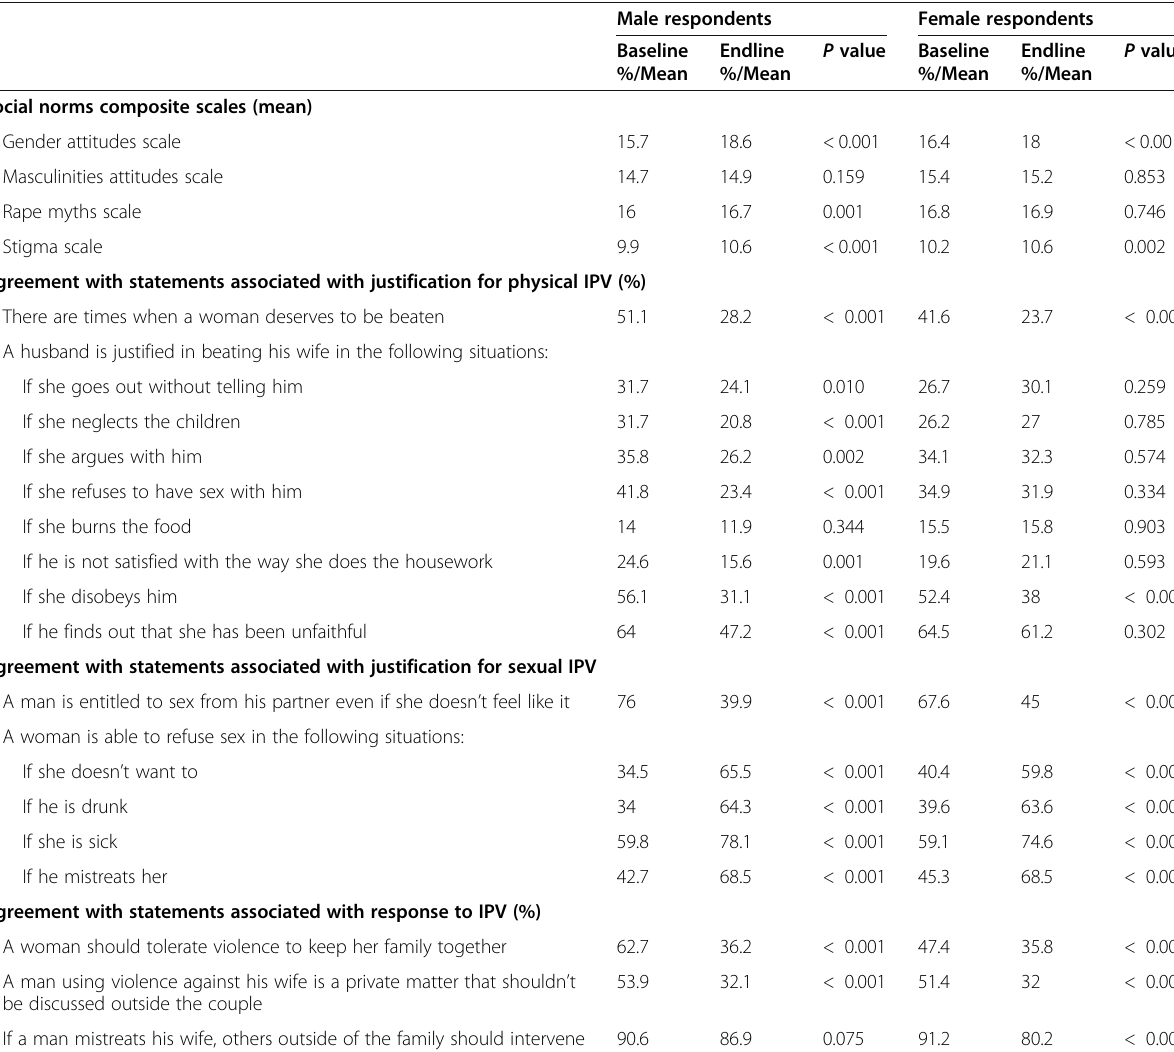
Table 4 Baseline and endline mean scores and frequencies for social norms and attitudes associated with gender and violence against women, disaggregated by gender of